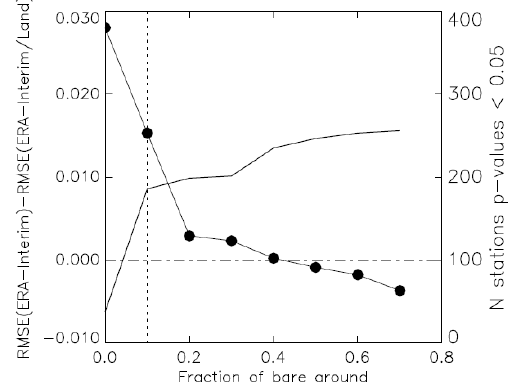
Figure 9. RMSE difference between ERA-Interim and ERA- Interim/Land (solid line, left y axis) as a function of the fraction of bare ground. The number of in situ stations (line with solid dots, right y axis) with significant correlations is also presented. Sensi- tivity to fraction of bare soil is only pronounced above the threshold indicated by the vertical dashed line.